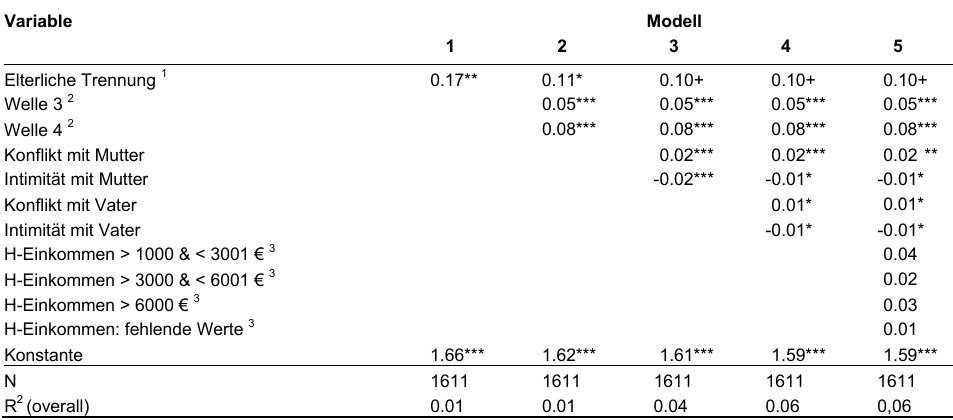
Tabelle 1 : Regression elterlicher Trennung auf Depressivität